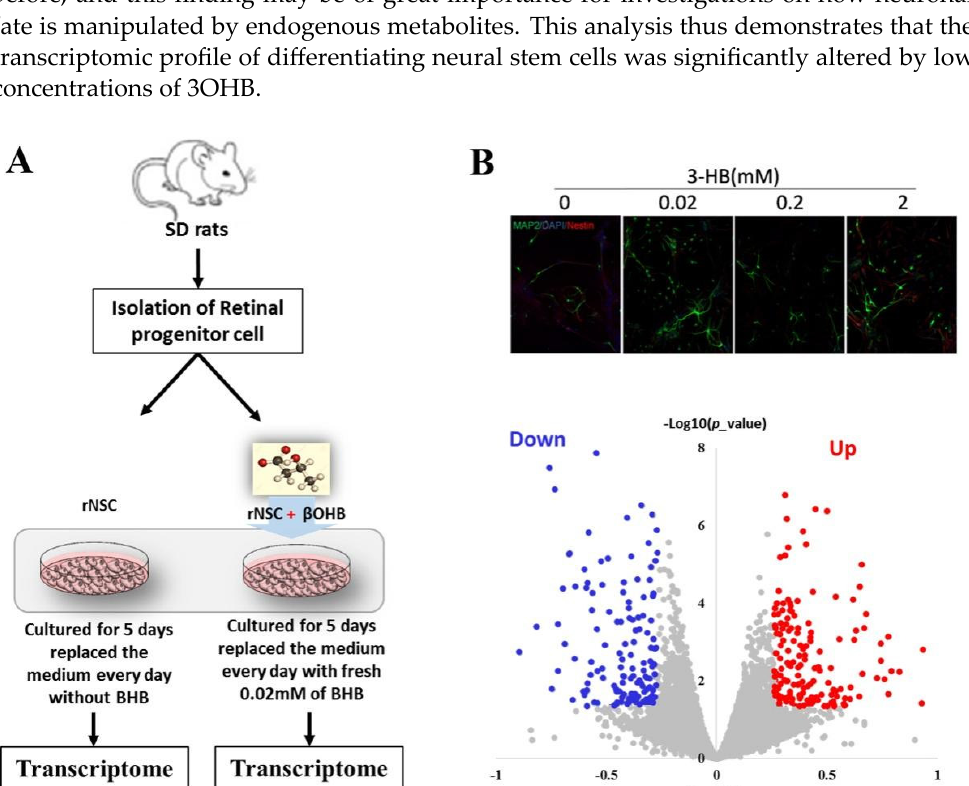
Figure 4. BHB perturbed chromatin bivalency and resulted in the alteration of neural differenti- ation processes. ( A ) Workflow of neural precursor cell isolation and 3OHB treatment for transcrip- tome analysis. ( B ) Up, immunocytochemical staining used to validate the alteration of the differen- tiation status of NSCs in the presence of 0.02, 0.2 and 2 mM 3OHB; down, volcano plot of the